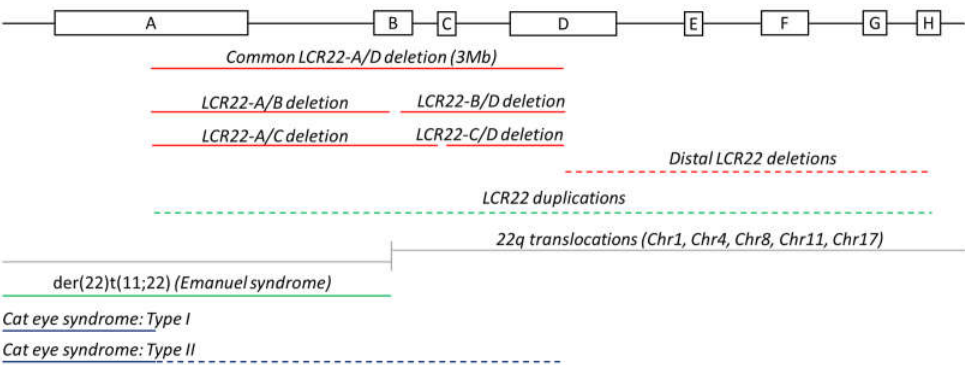
Figure 1. Rearrangements between low copy repeats on chromosome 22. Organization of LCR22s-A until -H. Schematic overview of the rearrangements observed between LCR22s with dotted lines indicating the options of crossovers between different blocks. The red lines indicate deletions. The green lines represent duplications. The grey lines show the rearrangement locus in the recurrent translocations involving chromosome 22. The dark blue lines show the triplication of a fragment in cat eye syndrome. The dashed lines cover different-sized CNVs.